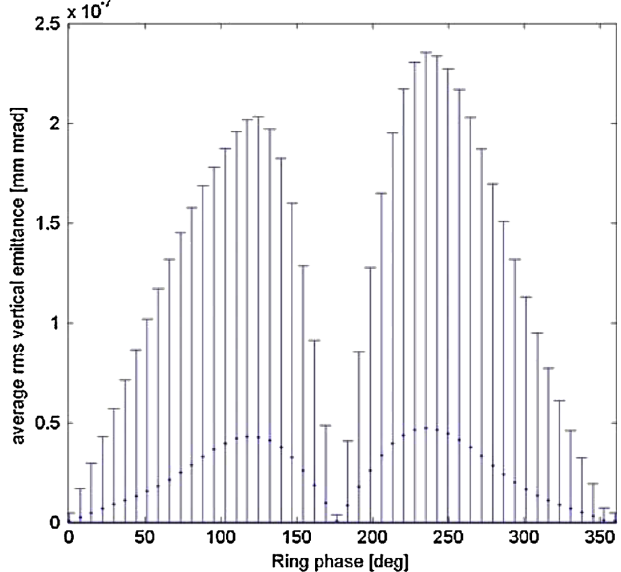
FIG. 22. (Color) Average rms emittances for a beam passing 1 mm off axis in the vertical